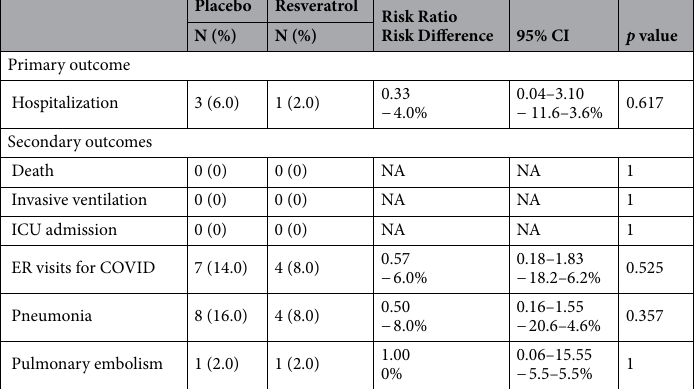
Placebo Resveratrol